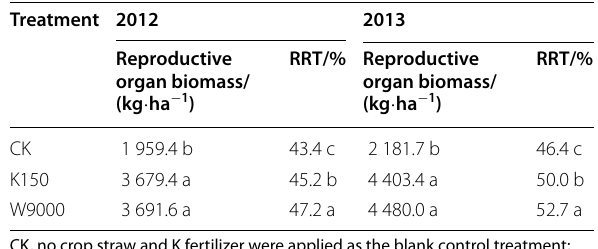
Table 1 Reproductive organ biomass accumulation and ratio of reproductive organ biomass to total biomass (RRT) in 2012 and